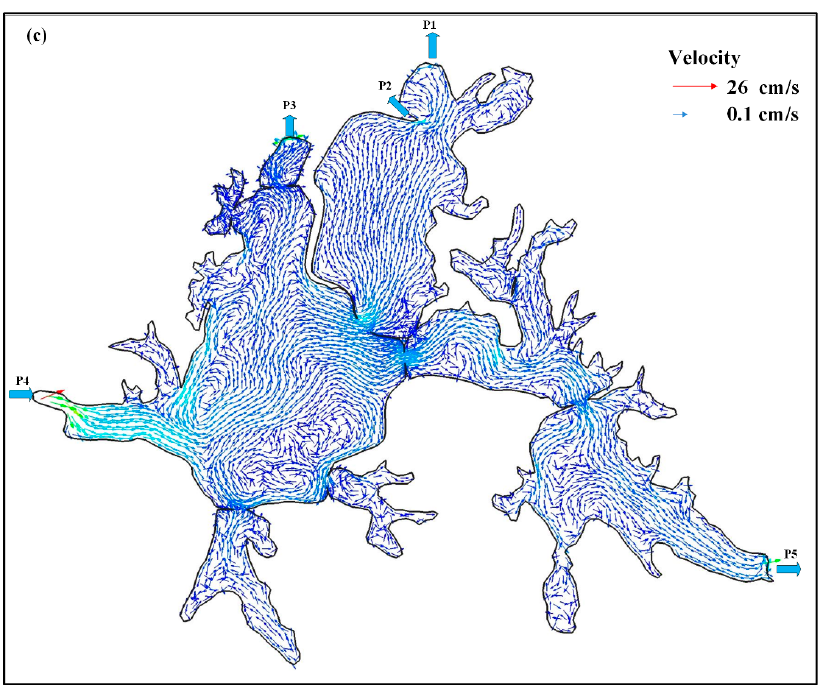
Figure 12. Depth-averaged circulation on July 15, 2011 under scenarios S1 ( a ), S2 ( b ), and S3 ( c ). Table 5. Hydrodynamic indicators under different water diversion scenarios.